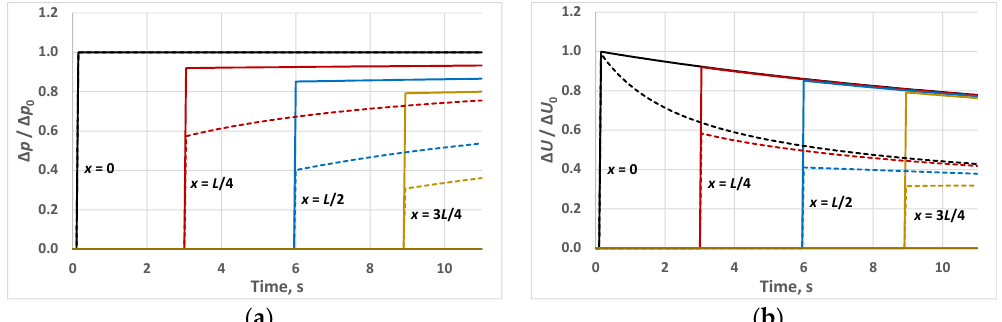
Figure 7. Influence of fluid compressibility on wavefront propagation. (Continuous lines: Δ p 0 = 1 kPa; Broken lines: Δ p 0 = 10 kPa.). ( a ) Pressure. ( b ) Velocity.